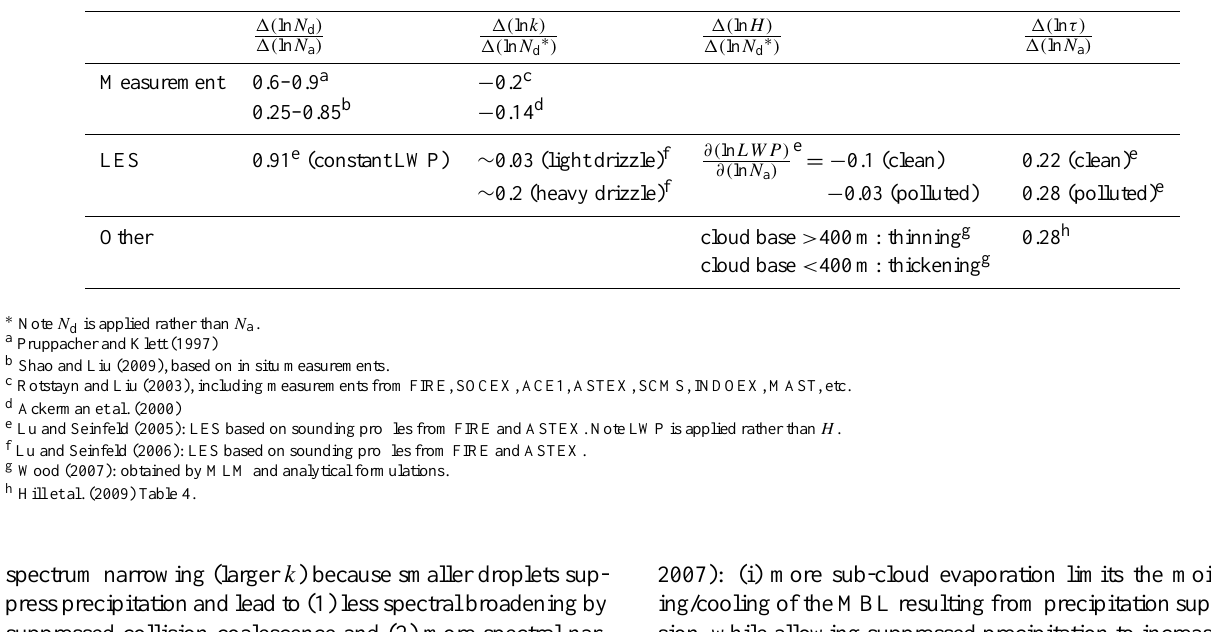
Table 2. Sign and magnitude of each term in Eq. (3) from previous